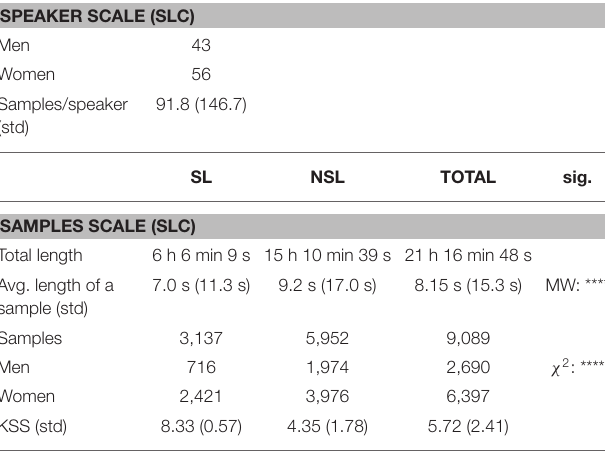
TABLE 1 | Global statistics of the Sleepy Language Corpus (SLC).